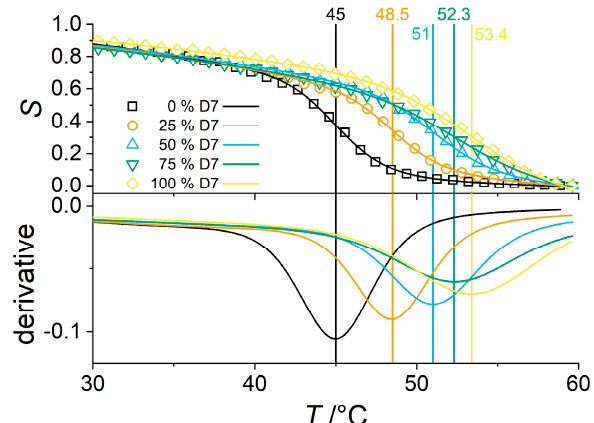
Figure 5. ( Top ) VPTT of four D7/H-pNIPMAM co-polymer microgels in water with different co- polymer ratios. The percentage of H-pNIPMAM is indicated in the legend. ( Bottom ) Derivative of the fit of the experimental data in the upper part. The vertical lines at the peaks indicate the VPTT of each microgel.